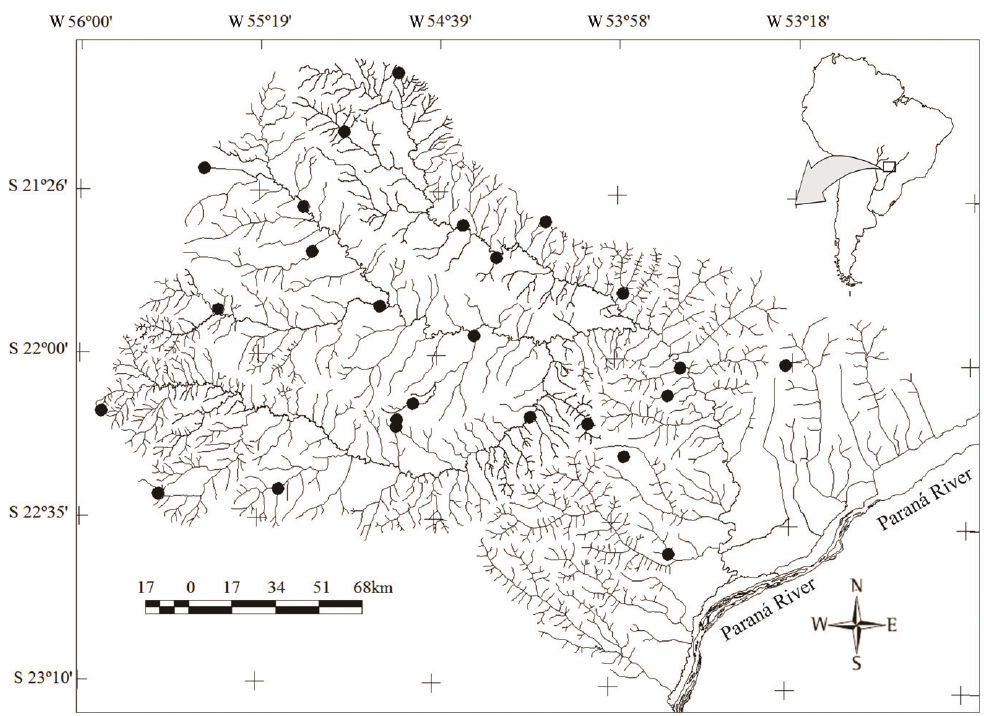
Figure 1. Sampling sites in the Ivinhema River basin, Upper Paraná River from 2001 to